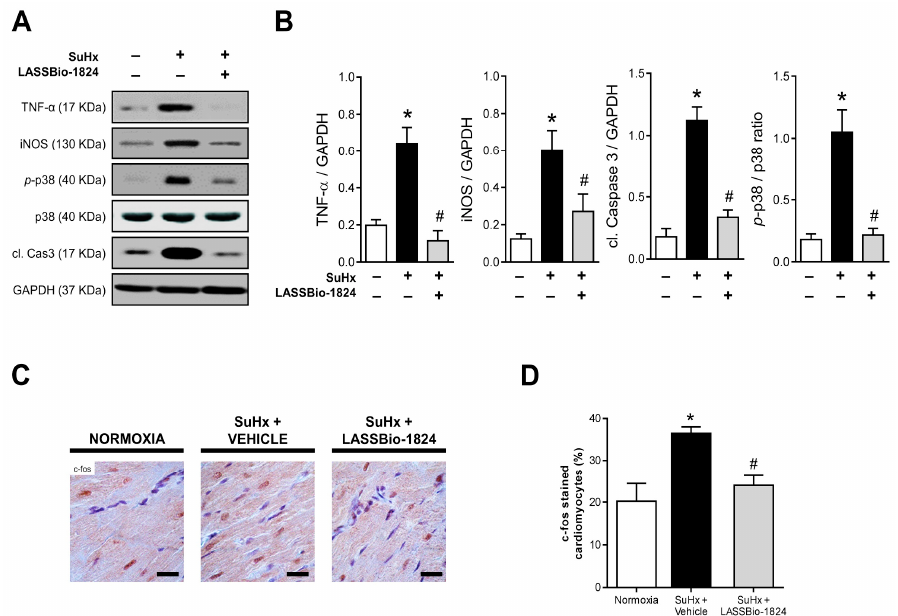
Figure 6. Effect of LASSBio-1824 on RV content of tissue inflammation mediators and cardiac stress and apoptosis in SuHx. ( A ) Representative images of TNF- α , iNOS, phosphorylated and total p38, cleaved caspase 3 and GAPDH immunodetection after Western blot ( n = 5 biological replicates). ( B ) Relative densities of TNF- α , iNOS, cleaved caspase 3 and phosphorylated p38 in RV samples, respectively ( n = 5 rats per group). ( C) Representative micrographs of c-fos immunohistochemistry in RV sections. Bars represent 20 μ m. ( D ) Brown-stained cardiomyocyte nuclei abundance in RV samples ( n = 5 rats per group). cl., cleaved; GAPDH, glyceraldehyde-3-phosphate dehydrogenase; iNOS, inducible nitric oxide synthase; RV, right ventricle; TNF, tumor necrosis factor. * p < 0.05 compared to normoxia. # p < 0.05 compared to SuHx + Vehicle.